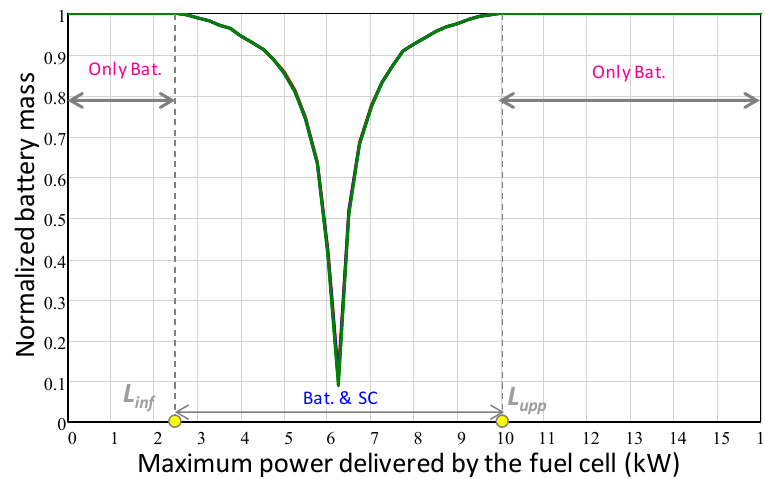
Figure 10. Normalized battery mass, considering the maximum energy delivered from the secondary energy sources during a driving cycle, as well as the storage of the energy from the regenerative braking periods, for the ECE-15 driving cycle.